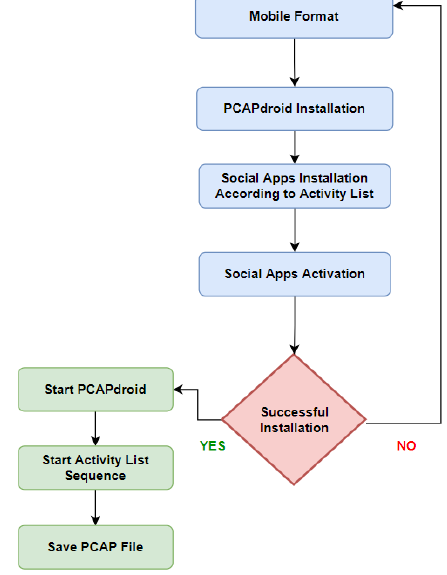
Figure 5. Class A data collection methodology workflow.